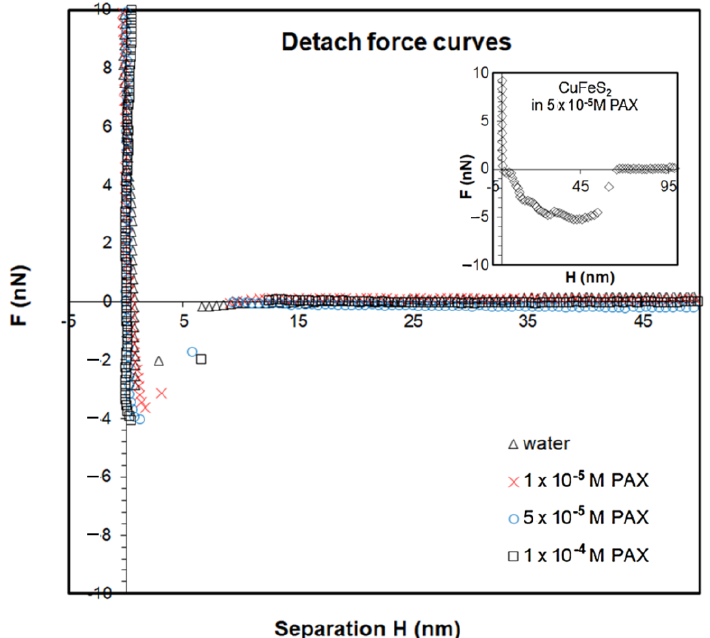
Figure 16. The detach force (F) measured between an AFM probe and a bornite plate soaked in solutions at pH 6 as a function of the separation (H) between the probe and the plate by applying an AFM force measurement. (Δ) in water , (×) in the 1 × 10 − 5 M PAX solution, (o) in the 5 × 10 − 5 M PAX solution and (□) in the 1 × 10 − 4 M PAX solution. The inlet (◊) shows the detach force curve obtained with CuFeS 2 in the 5 × 10 − 5 M PAX solution.